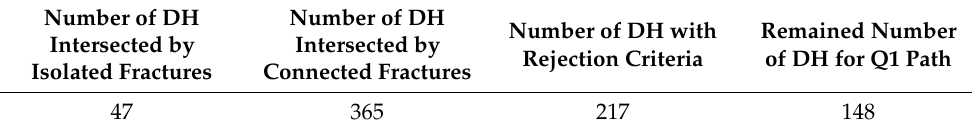
Figure 6. The schematic representation of the geometric DH rejection criteria. Canisters shown in red color indicate the rejected DHs. ( a ) A deposition hole position was rejected due to FPC prior to drilling; ( b ) Five deposition positions intersected by a fracture intersecting in a row are rejected. Table 3. The numbers of DHs obtained from the intersected fractures in the example DFN. Number of DH Intersected